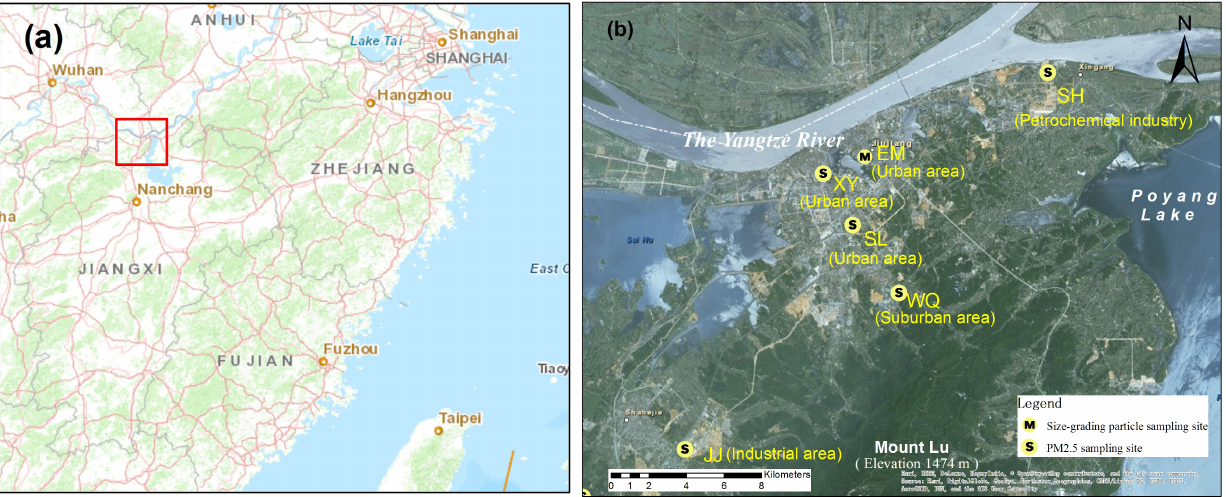
Figure 1. Location of aerosol sampling sites in Jiujiang, eastern